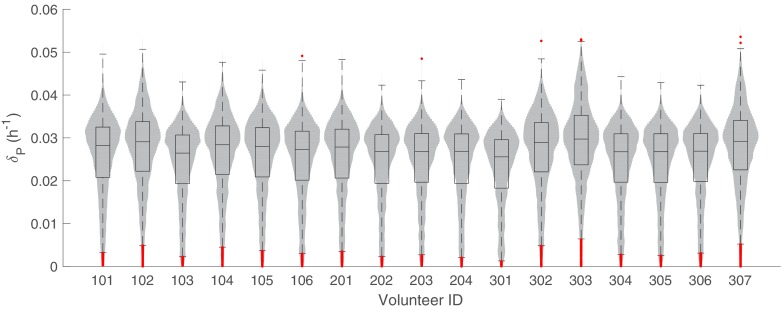
The marginal posterior distributions of the individual parameter of δP (death rate of asexual and sexual parasites) for all 17 volunteers.The violin plots (gray area) show the distributions of 5000 posterior samples. Box plots show the 25%, 50% (median) and 75% quantiles with outliers indicated by red dots. Relevant details of the individual parameter are provided in the Materials and methods in the main text.